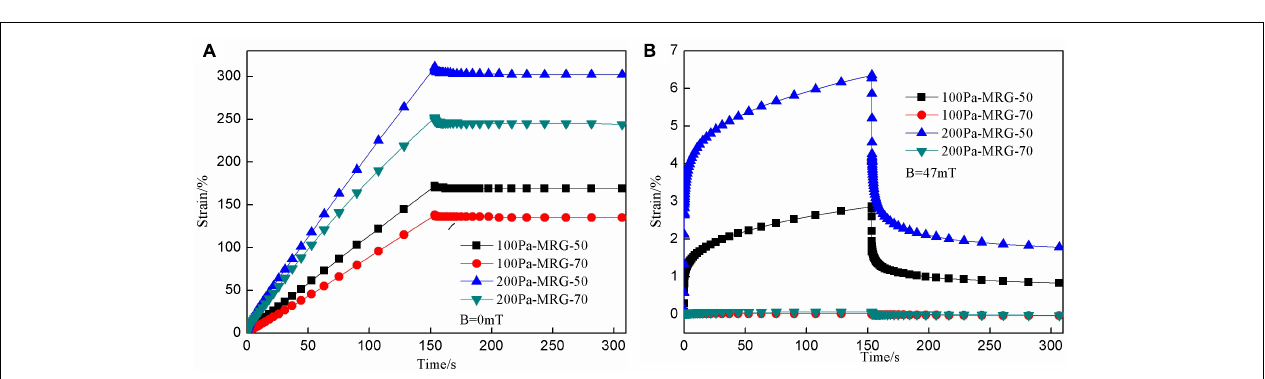
FIGURE 8 | Creep and recovery curves of MRG under different mass fractions (A) B = 0 mT; (B) B = 47